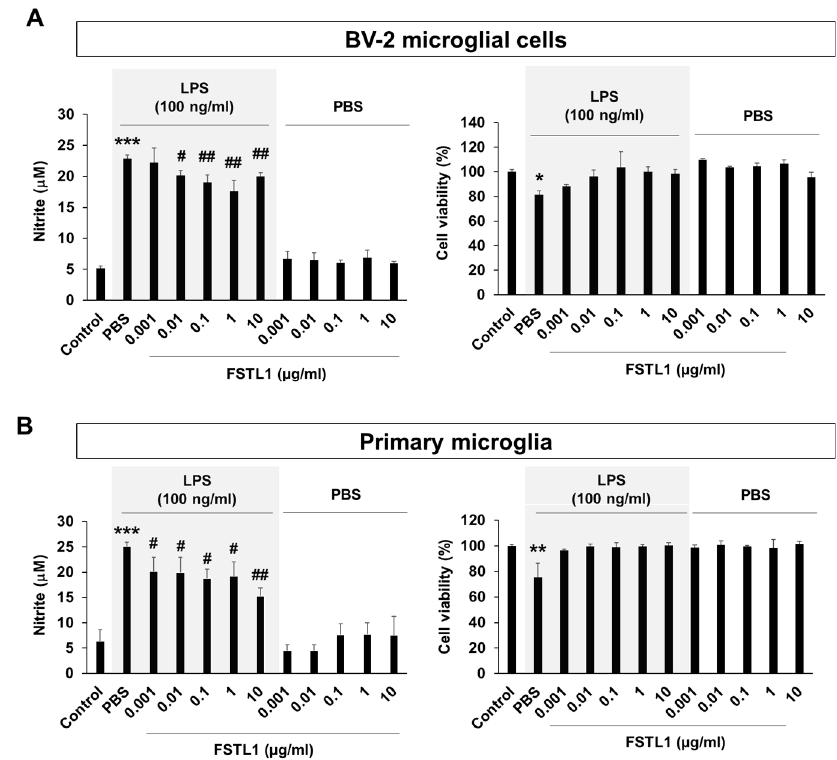
Figure 6. FSTL1 has a suppressive potential for microglial activation. ( A ) FSTL1 inhibited LPS-induced nitric oxide production in BV-2 microglial cells. BV-2 cells were stimulated with LPS (100 ng / mL) for 24 h after 2-h pretreatment with di ff erent concentrations of FSTL1 ( n = 3 each). ( B ) Suppressive e ff ect of FSTL1 on LPS-induced nitric oxide production in primary microglia. Data are presented as mean ± SEM. One-way analysis of variance was followed by the Tukey post-hoc test. * p < 0.05, ** p < 0.01, *** p < 0.001 vs. control; # p < 0.05, ## p < 0.01 vs. vehicle control (phosphate-bu ff ered saline, PBS).